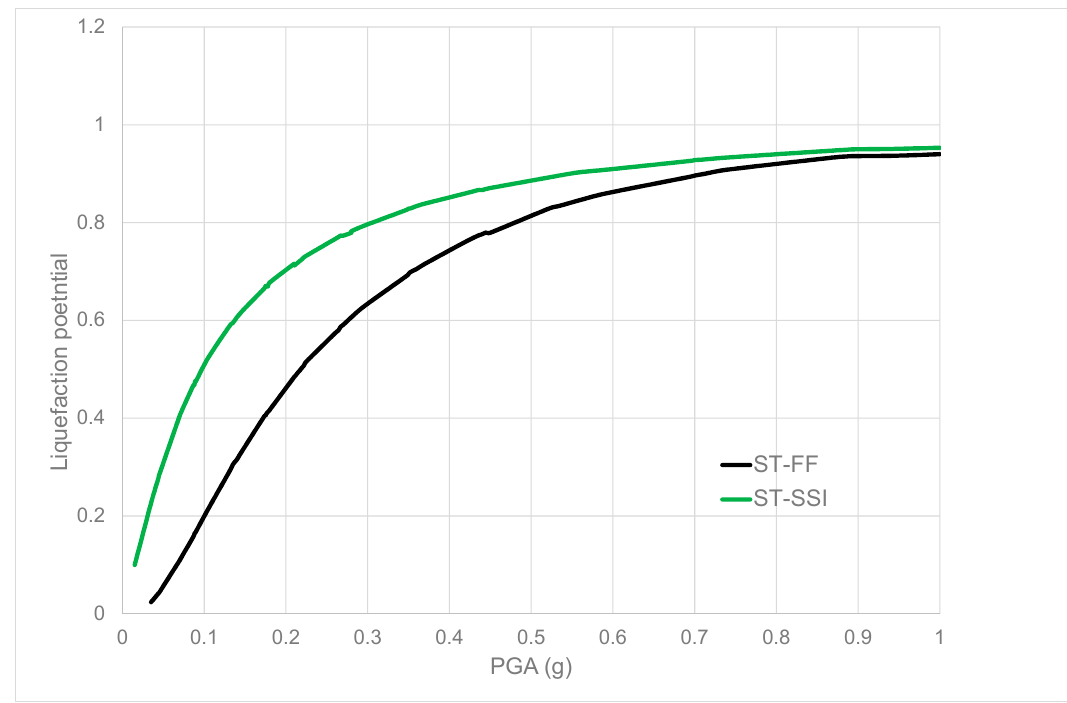
Figure 15. ST: FF-SSI LP curves comparison.